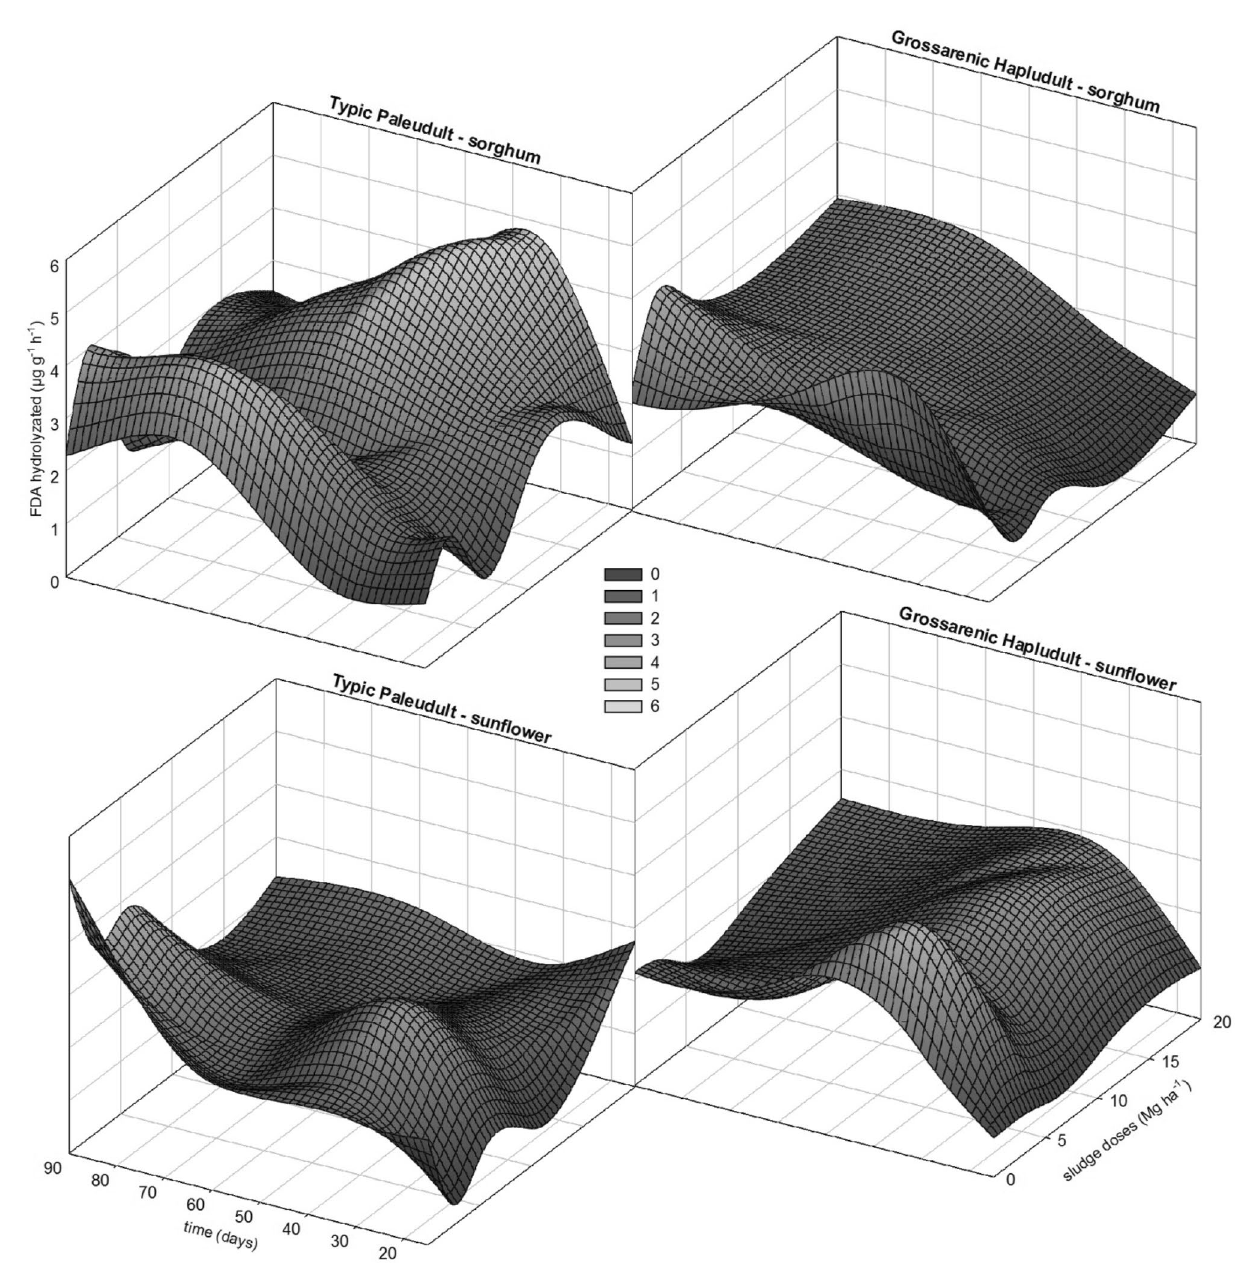
Fig. 5 FDA hydrolyzed (µg FDA g −1 h −1 ) on Typic Paleudult and Grossarenic Hapludult soils with sunflower and sorghum cultivation at 15, 30, 60, and 90 days after the amendment of industrial landfill sludge (ILS) doses (0, 2, 5, 10, and 20 Mg ha −1